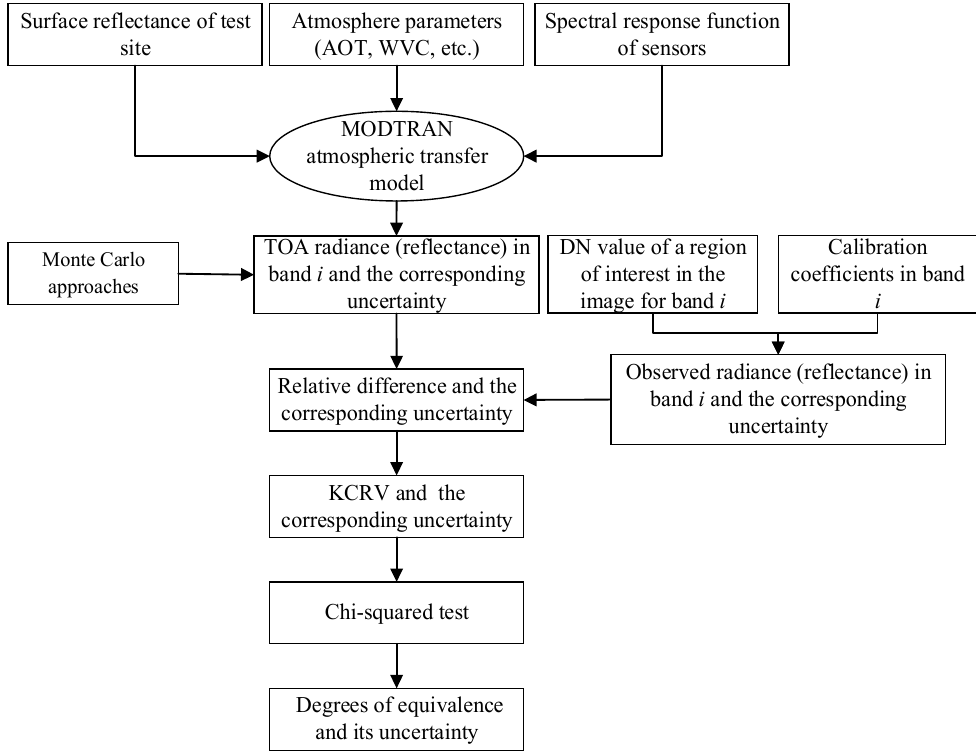
Figure 6. The flowchart of the method for determining the Key Comparison Reference Value (KCRV).